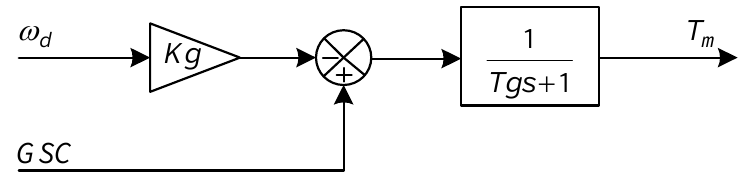
Figure 2. Schematic diagram of the governor.